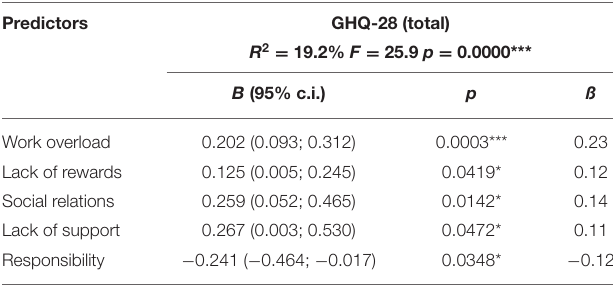
TABLE 8 | The effect of partial psychometric measures SWEQ and level of education on the overall mental health level.